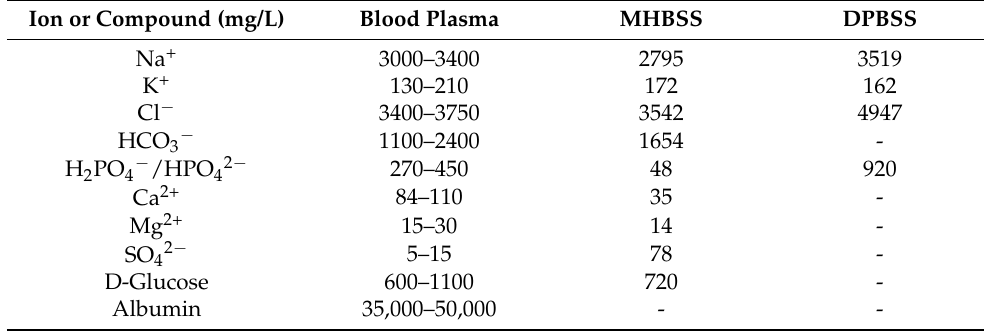
Table 1. Ion concentration of human blood plasma, compared to the test solutions